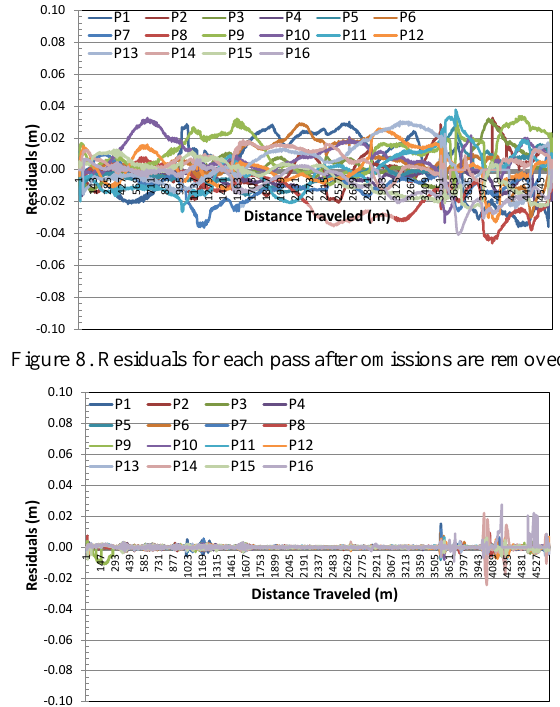
Figure 9. Residuals for each pass after final MPA